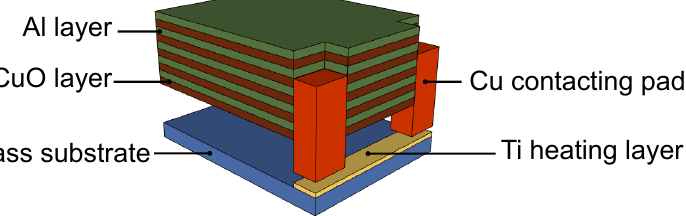
Figure 1. Schematic overview of the built-up sample used to study the thermite reaction (not to scale). The multilayer and the pads in the drawing are lifted to expose the Ti heating layer. Prior to the deposition of the multilayer, a titanium layer was deposited on the edge of the substrate. Contacting electrical pads, made from Cu tape, were placed on top of the titanium layer. The Cu pads were shielded during the deposition of the multilayers. Five bilayers were deposited. The first layer deposited was a CuO thin